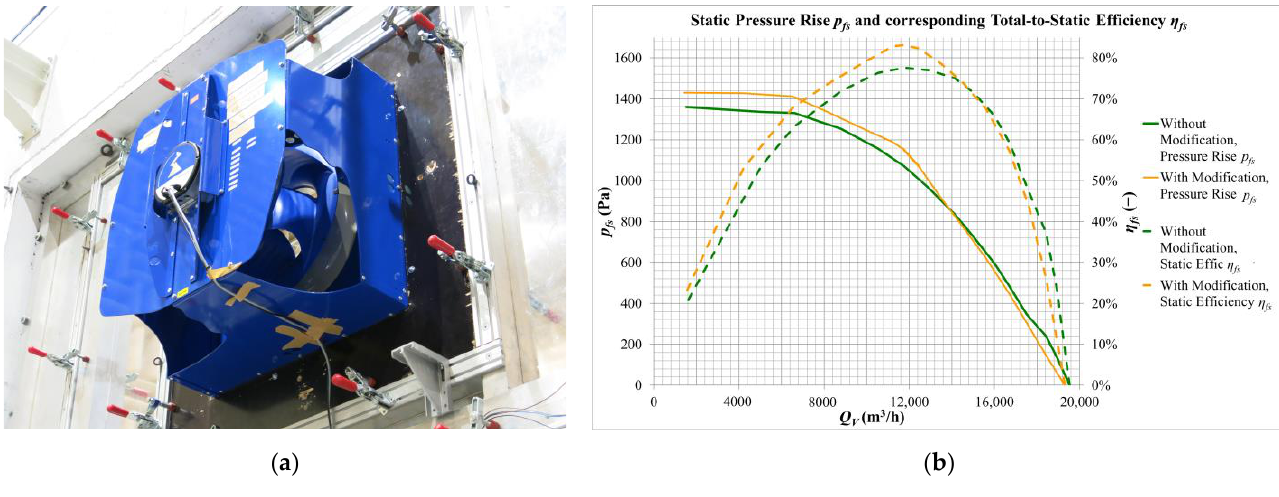
Figure 9. Experimental results for a fan with downstream modification: ( a ) photograph of implementation of a downstream modification on test rig; ( b ) and characteristic curves of static pressure rise p fs and total-to-static efficiency η fs .